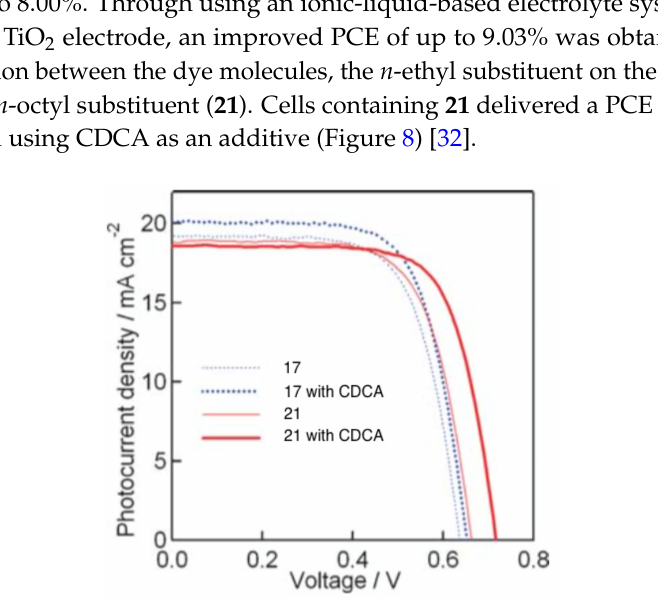
Figure 8. Current density vs. voltage characteristics for DSSCs with indoline dyes 17 and 21 as sensitizers with/without chenodeoxycholic acid (CDCA) under AM1.5 simulated sunlight (100 mW cm − 2 ) illumination. (reprinted with permission from ref. [32], Copyright 2008 Royal Society of